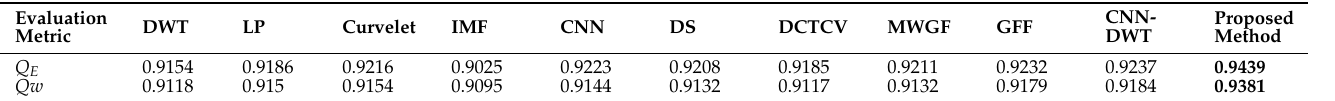
Table 34. The outcomes for the pepsi image and comparisons with existing techniques in the literature ([25]).